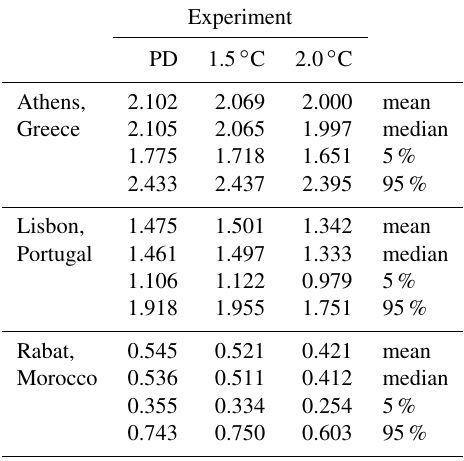
Table 5. Decadal mean winter (DJF) precipitation (mmd − 1 ) for sample locations from the CAM4 ensemble corresponding to the histograms in Fig.